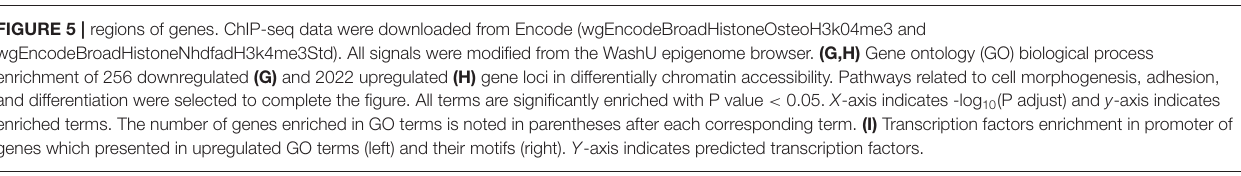
FIGURE 5 | regions of genes. ChIP-seq data were downloaded from Encode (wgEncodeBroadHistoneOsteoH3k04me3 and wgEncodeBroadHistoneNhdfadH3k4me3Std). All signals were modified from the WashU epigenome browser. (G,H) Gene ontology (GO) biological process enrichment of 256 downregulated (G) and 2022 upregulated (H) gene loci in differentially chromatin accessibility. Pathways related to cell morphogenesis, adhesion, and differentiation were selected to complete the figure. All terms are significantly enriched with P value < 0.05. X -axis indicates -log 10 (P adjust) and y -axis indicates enriched terms. The number of genes enriched in GO terms is noted in parentheses after each corresponding term. (I) Transcription factors enrichment in promoter of genes which presented in upregulated GO terms (left) and their motifs (right). Y -axis indicates predicted transcription